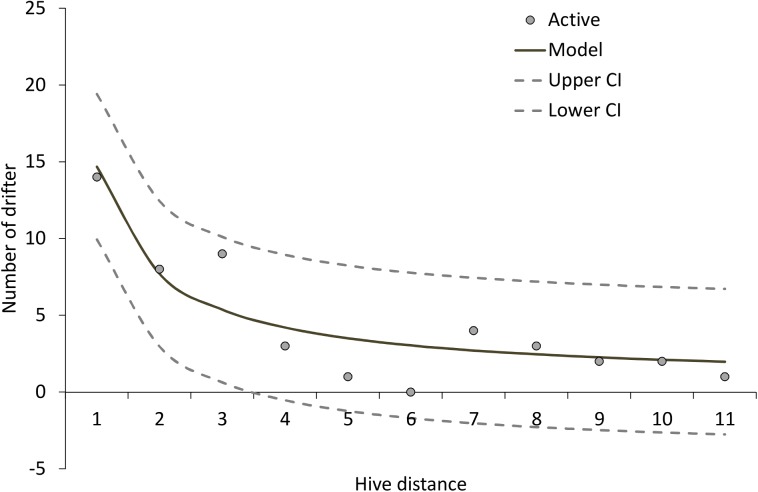
Number of bees drifting from neighbouring colonies (N = 47).The distance of “one” means that the bees came from the neighbouring colony, “two” from the colony next to the neighbouring colony and so on. The equation for the relationship is: y = a + b/x where a = 0.716 and b = 13.96.